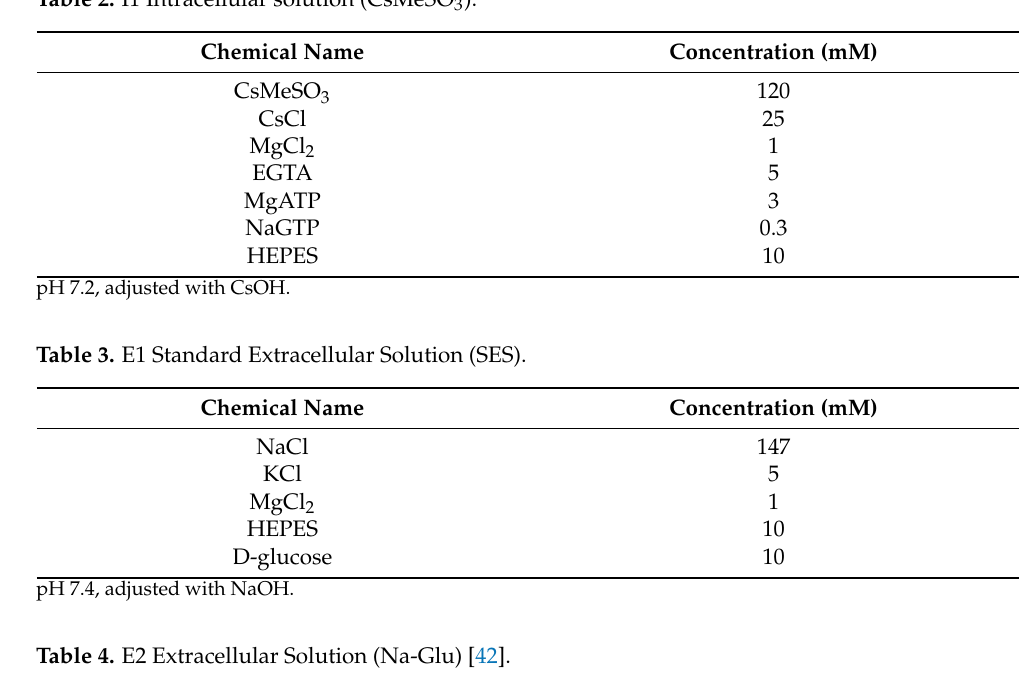
Table 2. I1 Intracellular solution (CsMeSO 3 ).